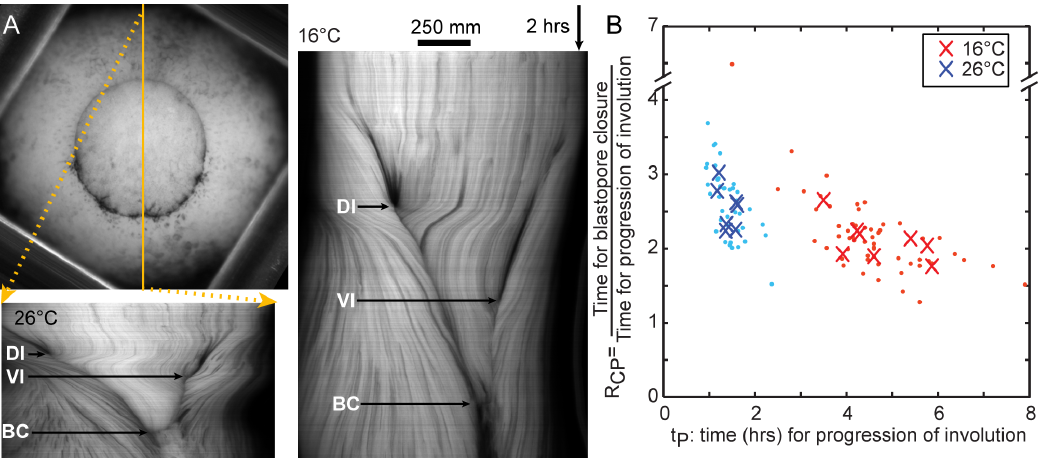
Figure 2. Blastopore closure at high and low temperatures. (A) Upper: vegetal view of an embryo showing the blastopore soon after the start of dorsal superficial involution. Lower left: kymograph of blastopore closure at 26 u C, taken along the yellow line from the dorsal side to the ventral side, showing the points when dorsal (DI) and ventral (VI) superficial involution begin, and when the blastopore closes (BC). Right: kymograph taken along a line from the dorsal to the ventral side at 16 u C. (B) The ratio (R CP ) of the time for blastopore closure to the time for dorsal-to-ventral progression of involution versus the time (t P ) for dorsal-to-ventral progression of involution. Dots indicate individual embryos. X’s indicate medians for clutches (4 to 8 embryos each).